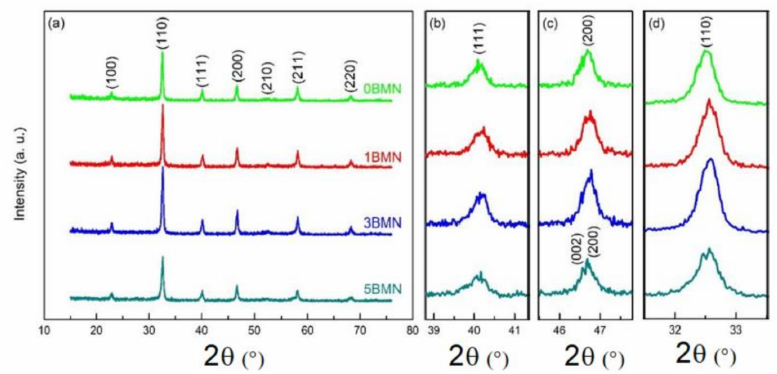
Figure 2. ( a ) XRD patterns of calcined (1 − x)NBT–xBMN samples; ( b – d ) show enlarged XRD patterns of (111), (200), and (110) diffraction peaks,